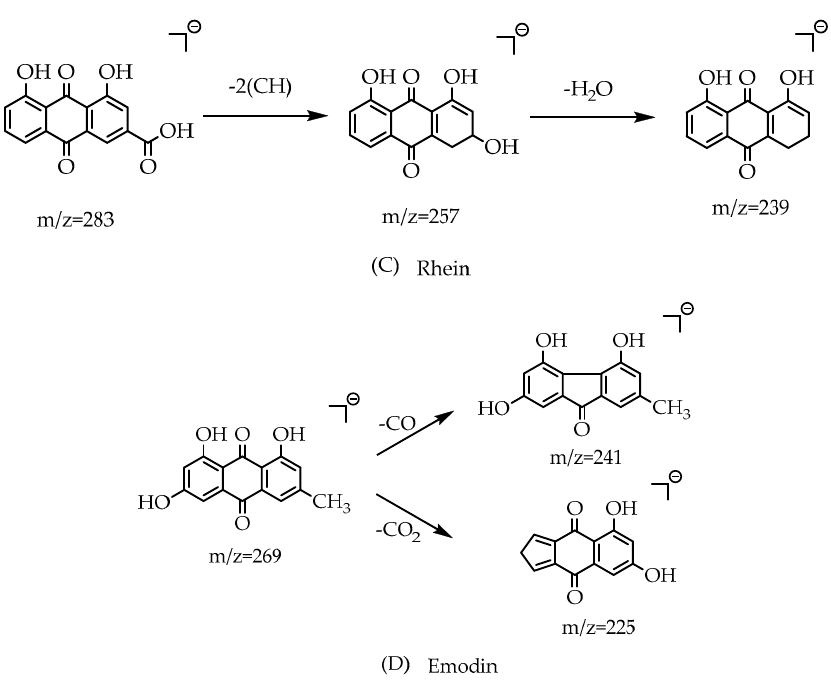
Figure 5. RDA cleavage and binding sites of four components.